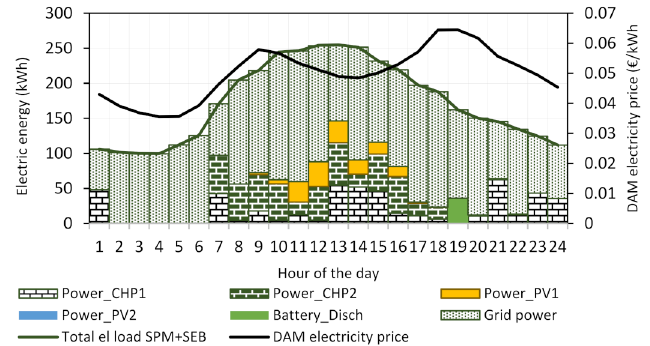
Figure 20. Electrical energy balance of the ILEC obtained with stochastic economic optimization for the representative winter day.